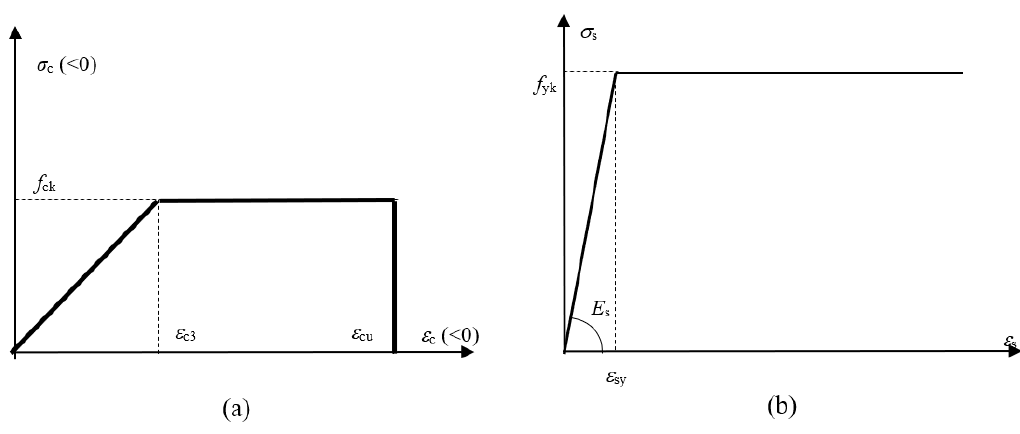
Table 3. Dynamic increase factor (DIF) for RC elements, extracted from [25]. Type of